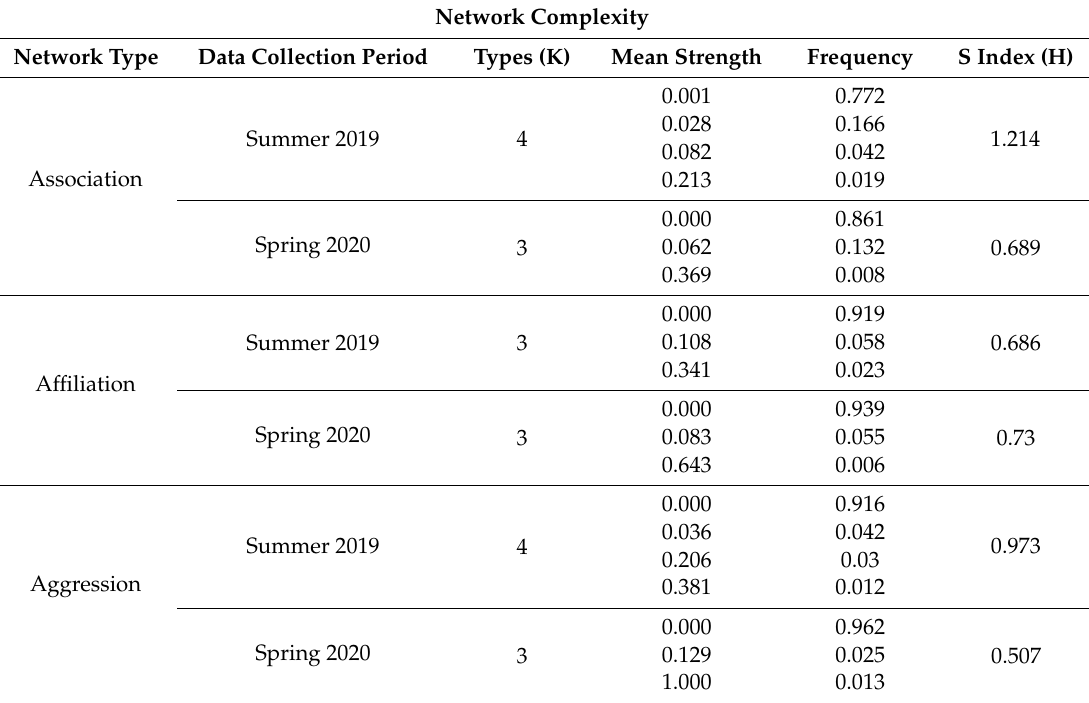
Table 1. This table shows the K types of interactions supported by binomial mixture modelling within each network, the mean strength of each type of interaction, the frequency of each type of interaction, and the Shannon index of entropy for each